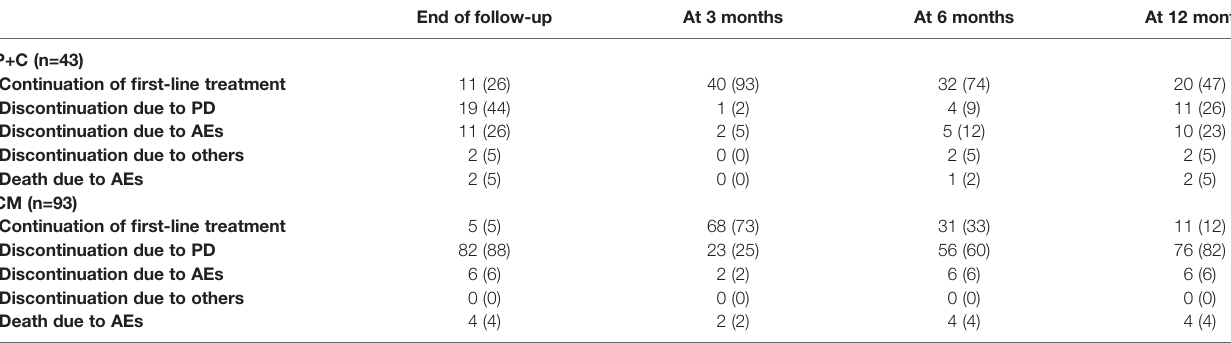
TABLE 3A | Reasons of discontinuation in different treatment groups.